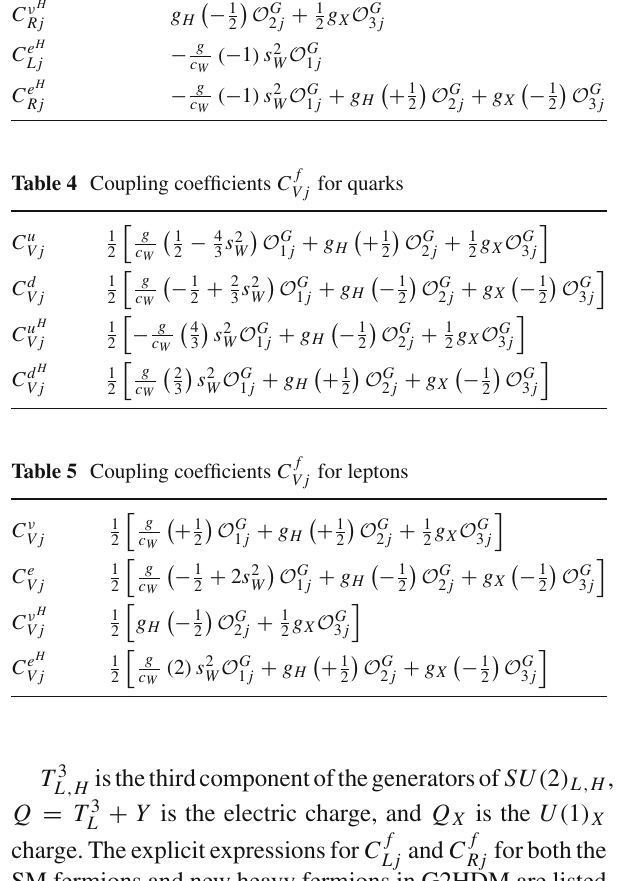
+ Y is the electric charge, and Q Q = T 3 L charge. The explicit expressions for C f SM fermions and new heavy fermions in G2HDM are listed in Table 2 for quarks and Table 3 for leptons. The vector cou- of quarks and leptons are listed in Tables 4 and 5 plings C f V j